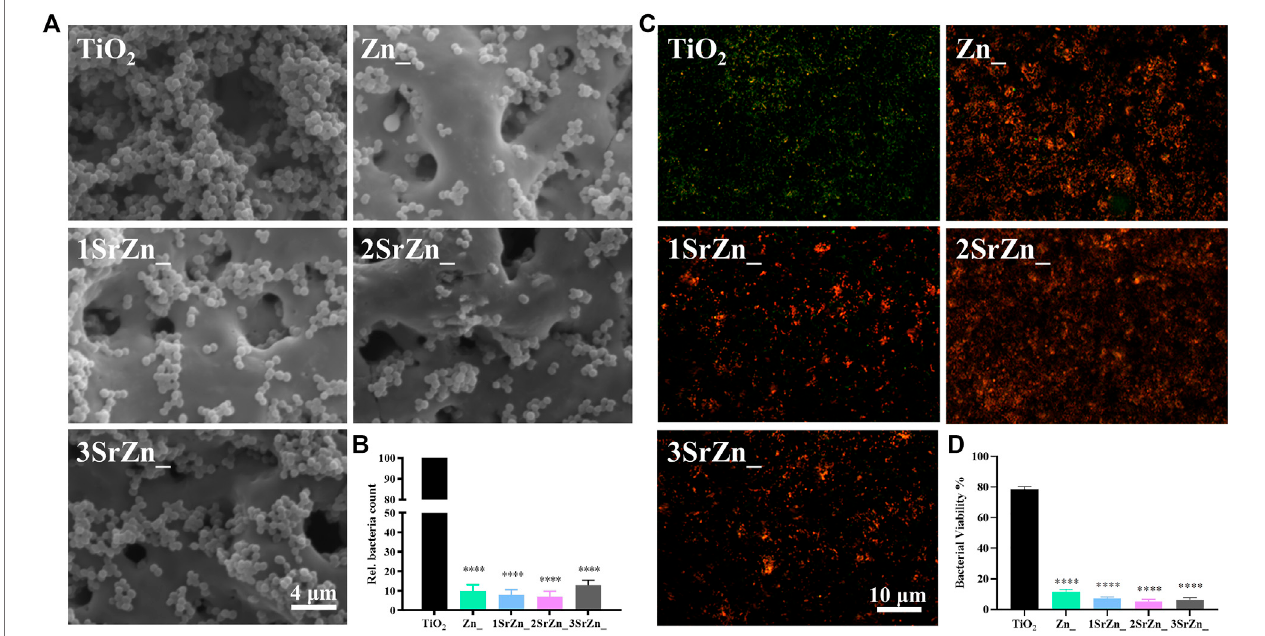
FIGURE 5 | The antibacterial ability of the Sr-Zn-augmented titanium surfaces. (A) SEM images of MRSA on the sample surfaces after 24 h of incubation. (B) The numbers of MRSA on the sample surfaces counted through spread plate evaluation with the bacteria solution dissociated from surface and then cultivated on standard agarculturemediumat37 ° Cfor24 h. (C) Immuno fl uorescenceassayofLive/Deadof P.gingivalis ondifferenttitaniumsurfaces(Livebacteria,green;Deadbacteria,red), and (D) their quantitative results compared with the TiO 2